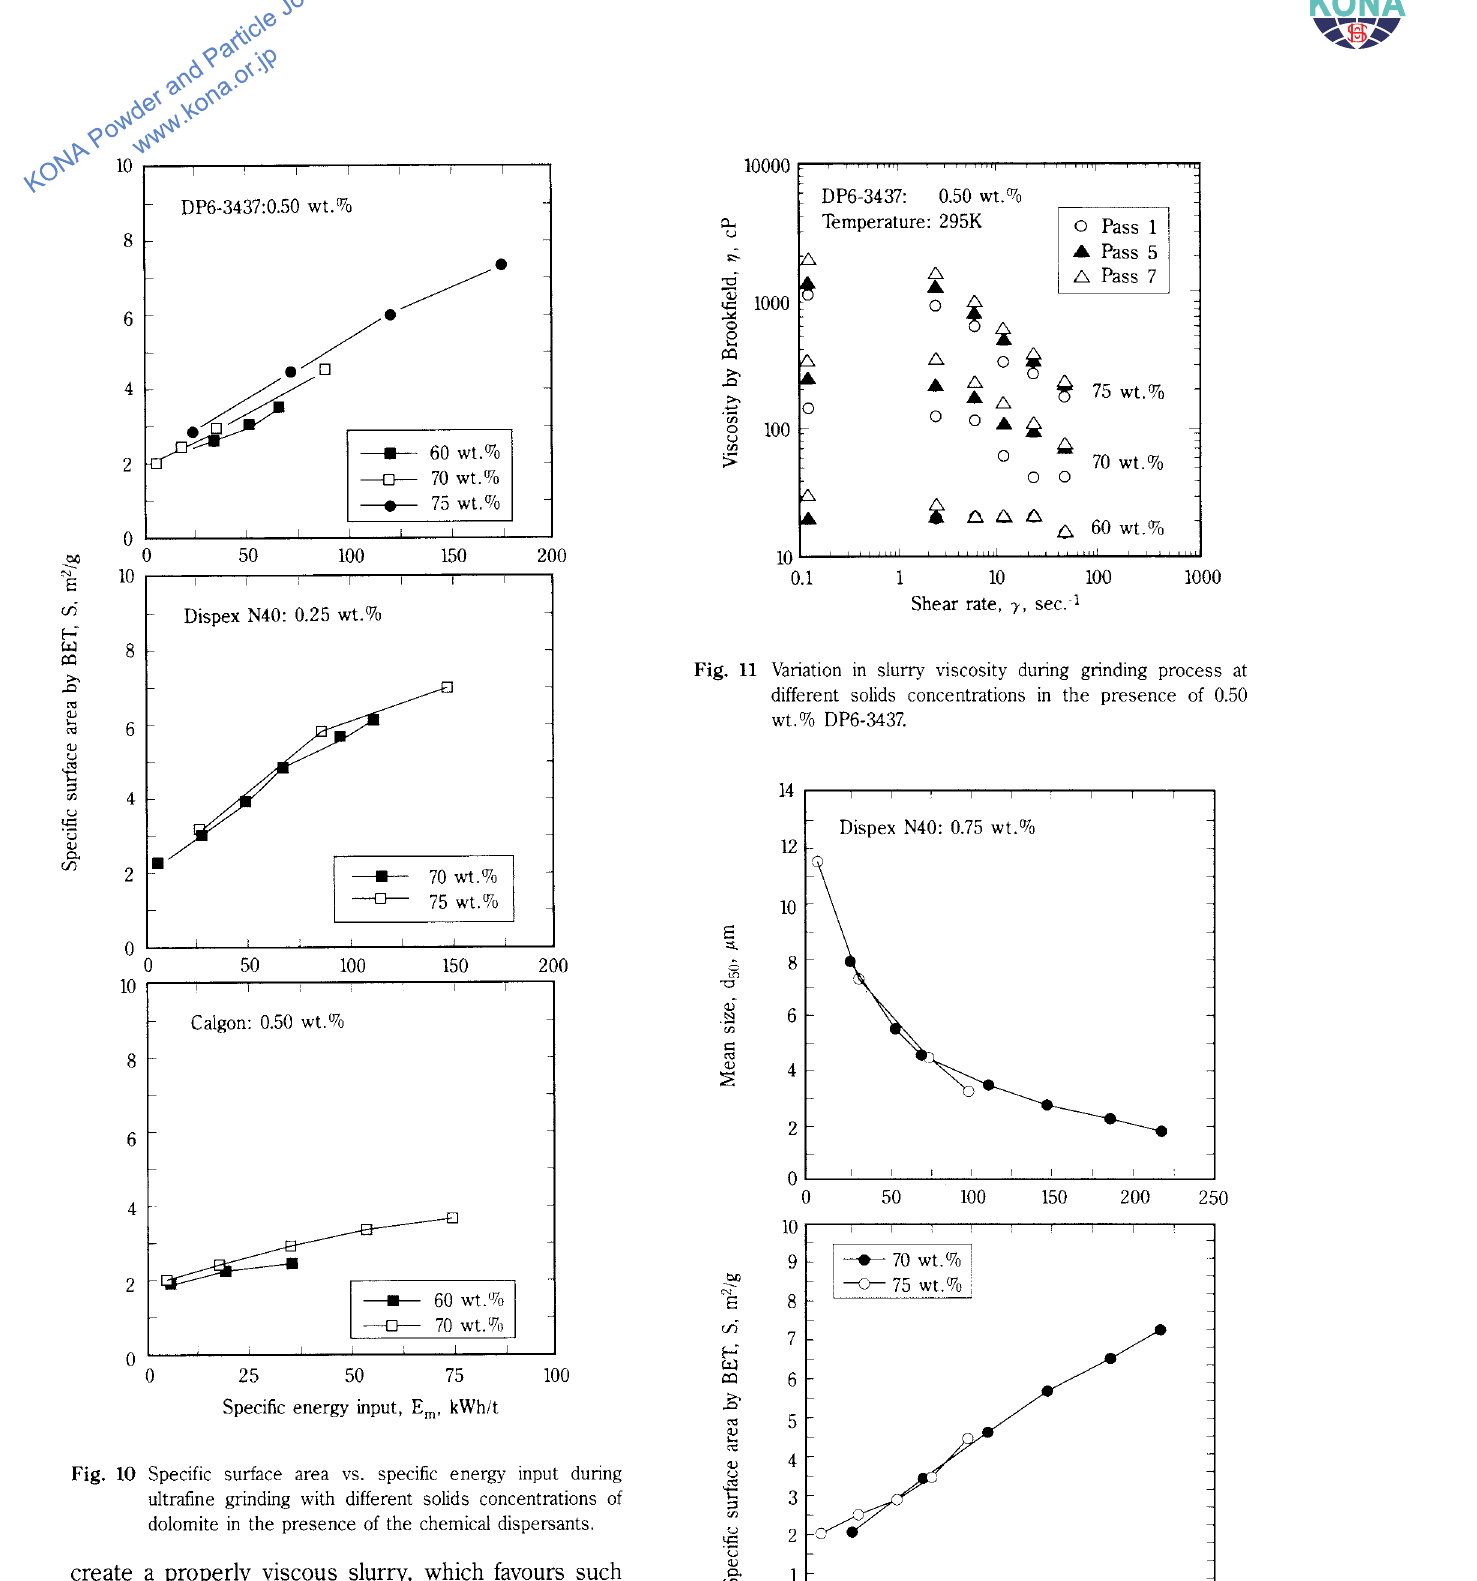
Fig. 10 Specific surface area vs. specific energy input during ultrafine grinding with different solids concentrations of dolomite in the presence of the chemical dispersants.